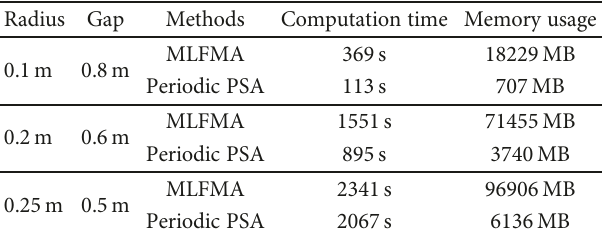
Table 2: Computation time and memory usage of MLFMA and periodic PSA for scattering of 32 × 32 elements.